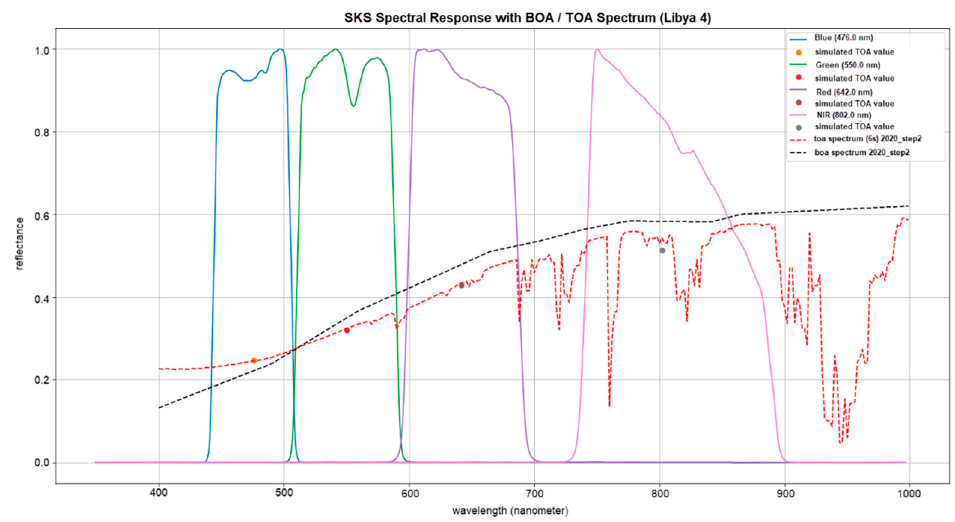
Figure 9. Simulation of TOA reflectance values for SkySat central wavelength.